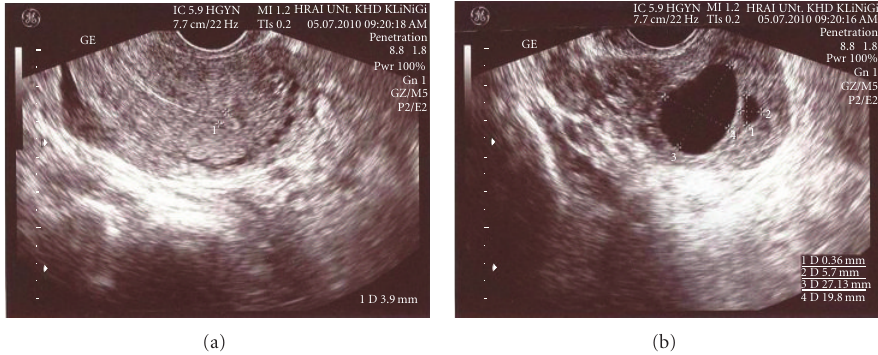
Figure 4: Regular endometrial ring and 27 × 20mm myometrial cystic area near of first distorted 8 × 6mm gestational sac residue.